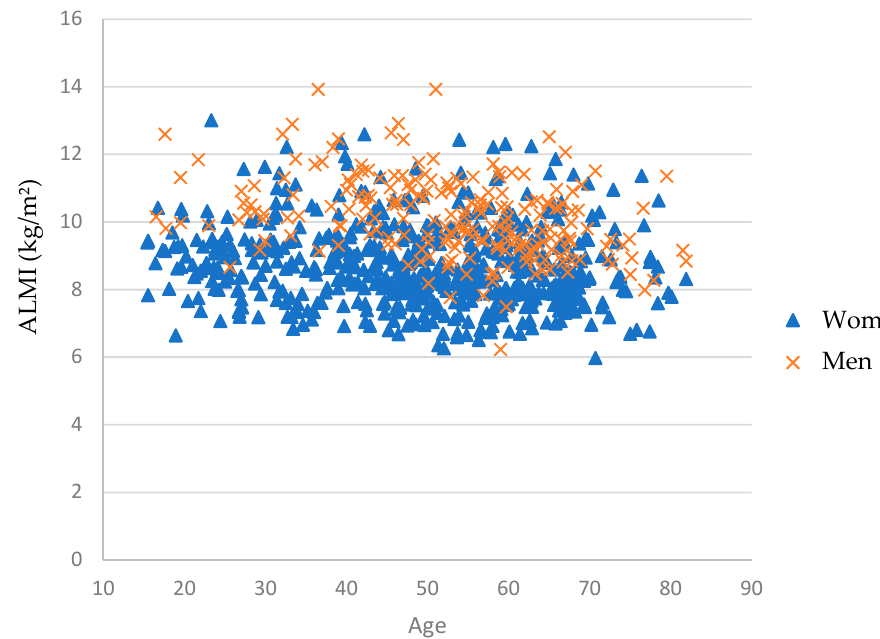
Figure 2. Scatter plots of the appendicular lean mass index (ALMI) in men ( × ) and women ( ∆ ) obese participants according to age.